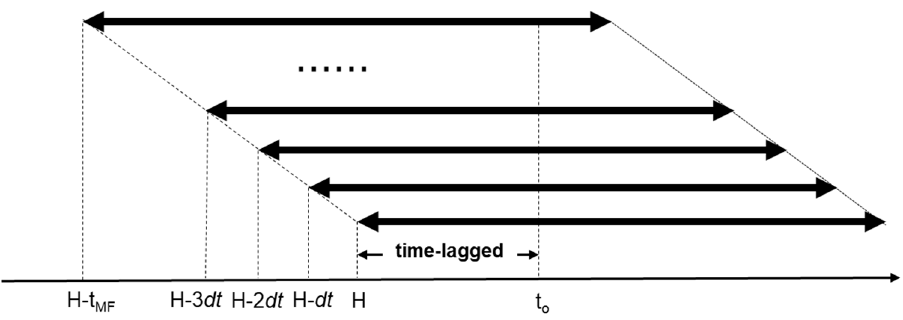
Figure 2. Sketch map of the construction of time-lagged ensemble members. (H is the current time, t 0 is the forecast lead time and dt is the prediction time interval of the model).